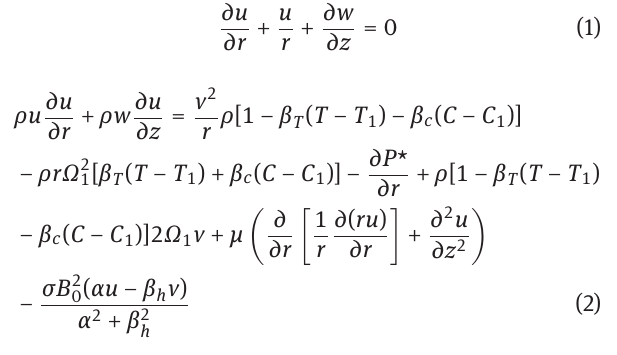
– The flow is laminar, steady and